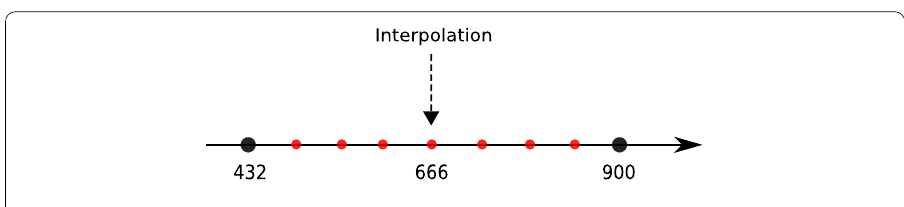
Fig. 3 Snapshots and assessment points in the 1D parameter space of C